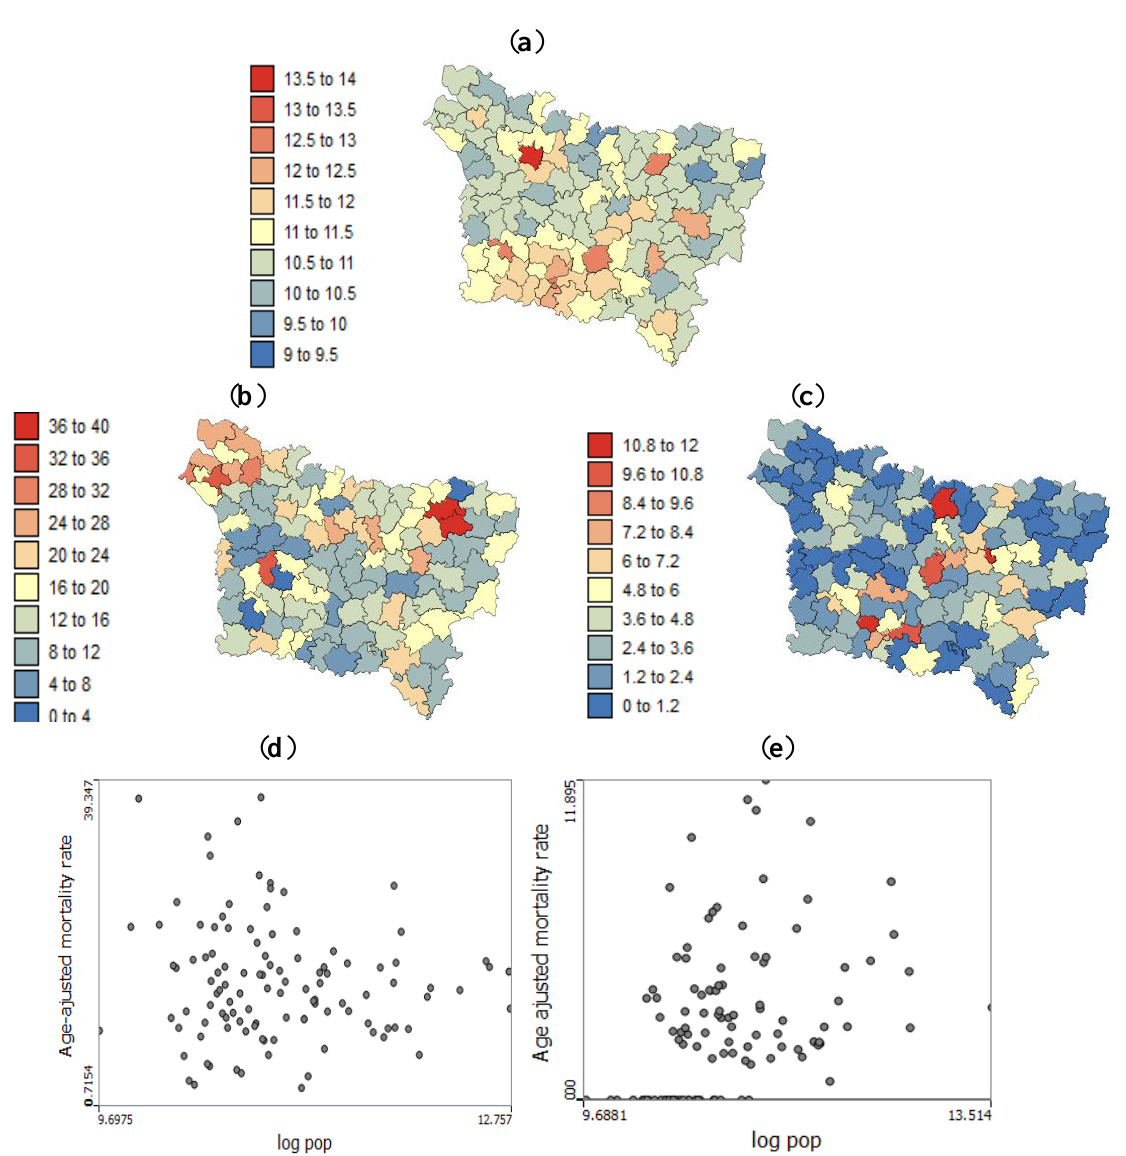
Figure 2. ( a ) Map of log population density. Geographic distribution of age-adjusted mortality rates per 100,000 person-years recorded over the period 2000–2009 for: ( b ) lip, oral cavity and pharynx; ( c ) pleura cancer mortality. The bottom scatter plots illustrate: ( d ) the age-adjusted mortality rates for lip, oral cavity and pharynx cancers plotted against population density and ( e ) the age-adjusted mortality rates of pleura cancers plotted against population density